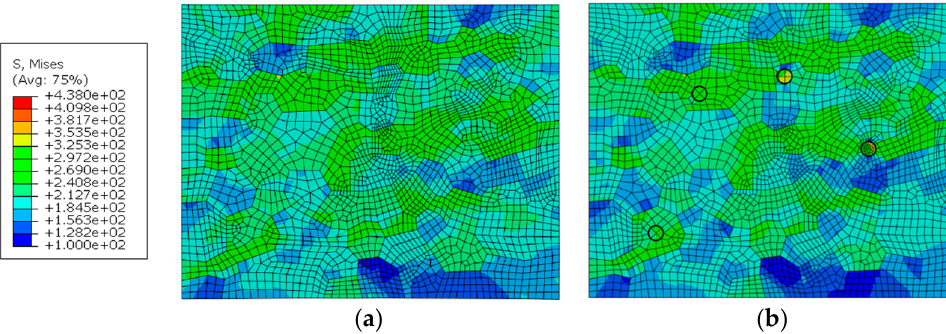
Figure 14. Von Mises stress distribution of WNZ in the joint models that, ( a ) only containing crystal characteristics, and ( b ) including crystal characteristics and hardening particles MPa.